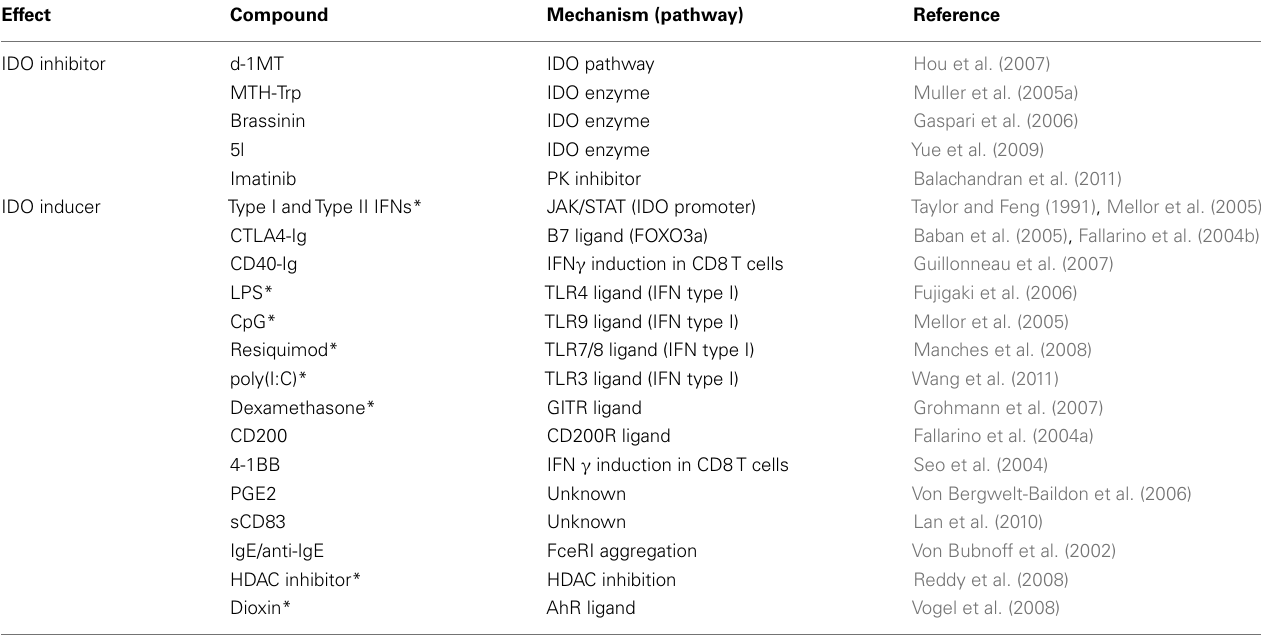
Table 1 | IDO pathway inhibitors and